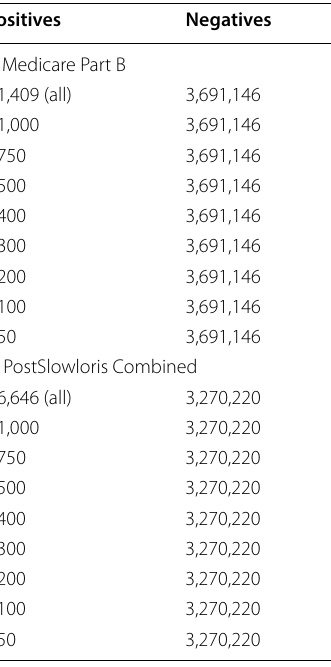
Table 1 Summary of